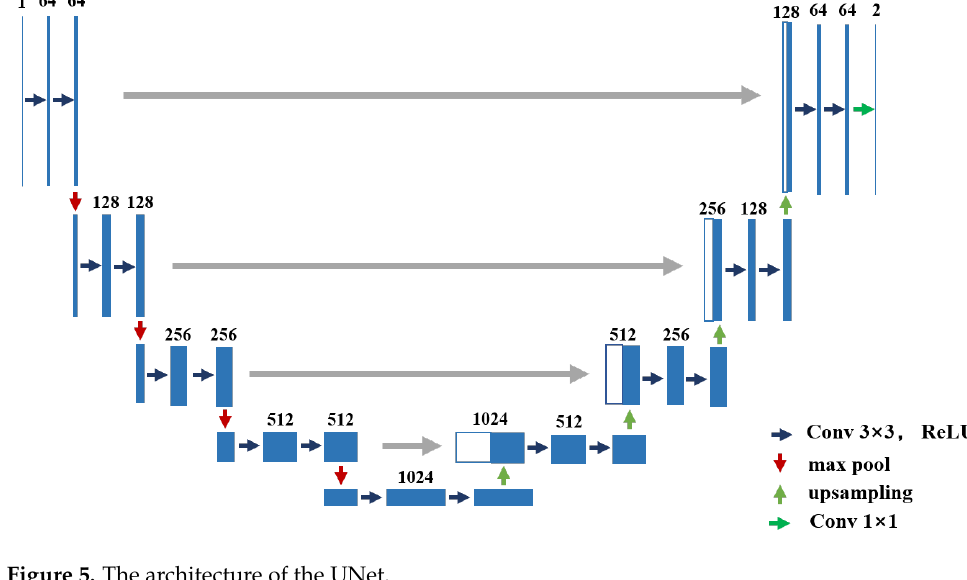
Figure 5. The architecture of the